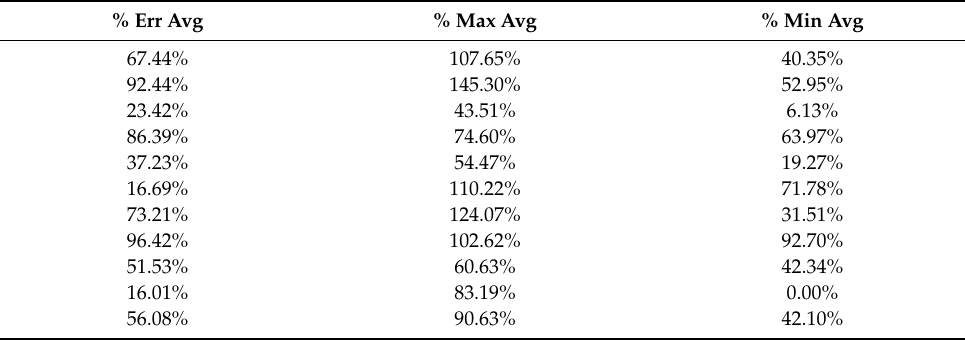
Table A152. Set 2, trials 41–50 data (average actual PR